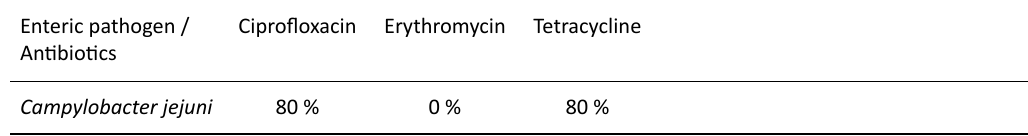
Table 4. The prevalence of Antibiotic resistance of Campylobacter jejuni Enteric pathogen /